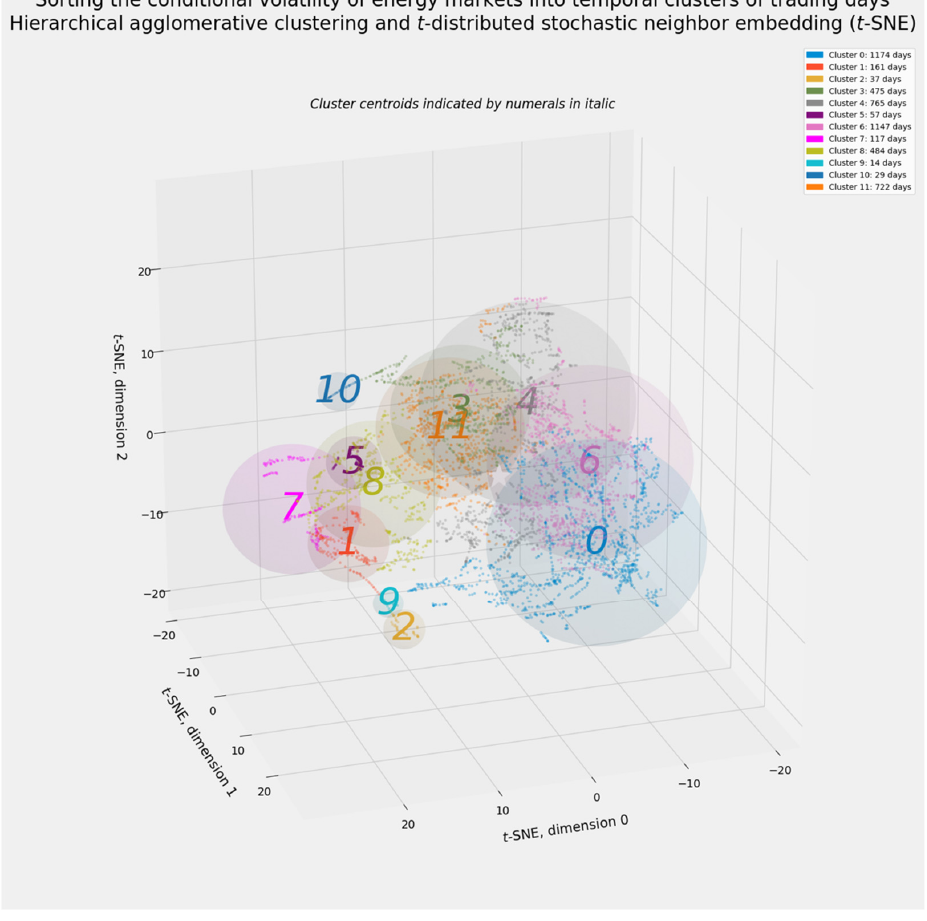
Figure 24. Hierarchical agglomerative clustering of energy-related markets—A t -SNE manifold.